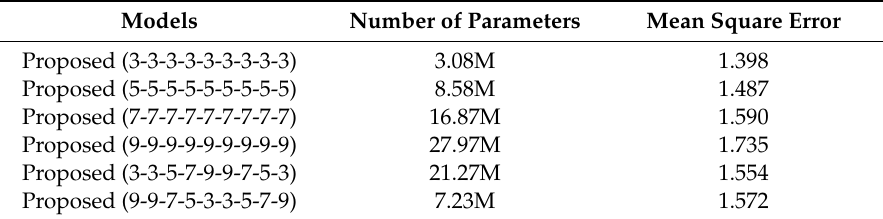
Table 1. Performance comparison among di ff erent convolution kernel sizes. Each number in bracket represents corresponding size of convolution kernel in each network layer. M denotes